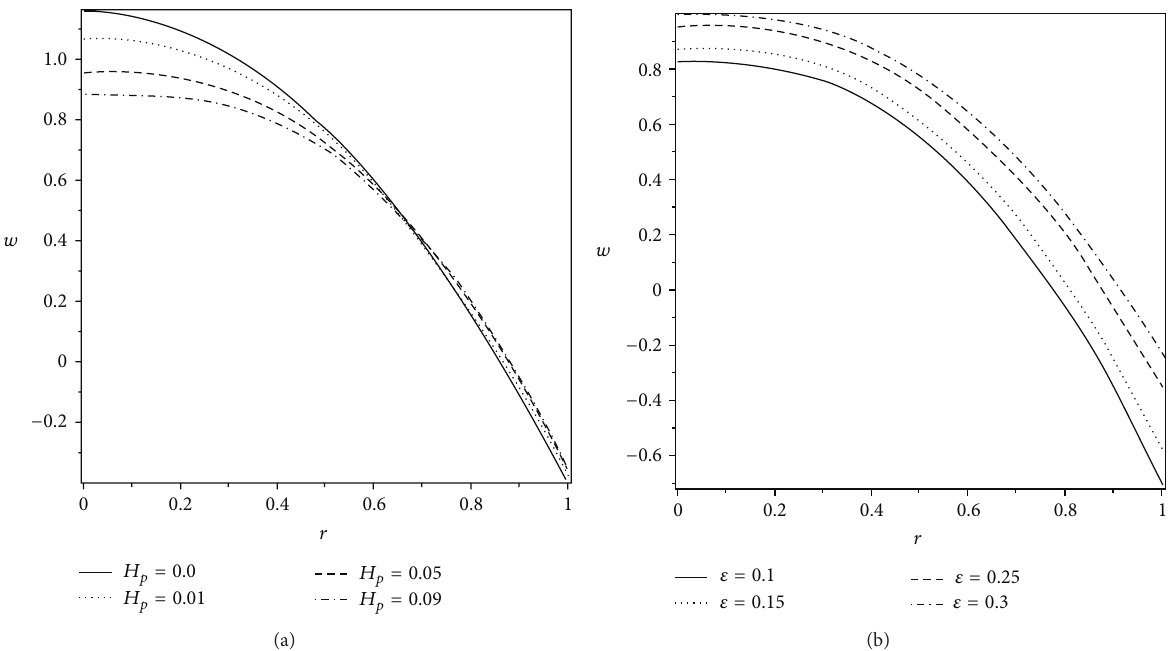
Figure 8: Variation of axial velocity 𝑤 at 𝑧 = 1 for different values of (a) 𝐻 𝑝 when 𝜀 = 0.25 and (b) 𝜀 when 𝐻 𝑝 = 0.05 . The other parameters are 𝛼 = 0.4 , 𝛽 = 0.4 , and 𝑄 = 0.95 .